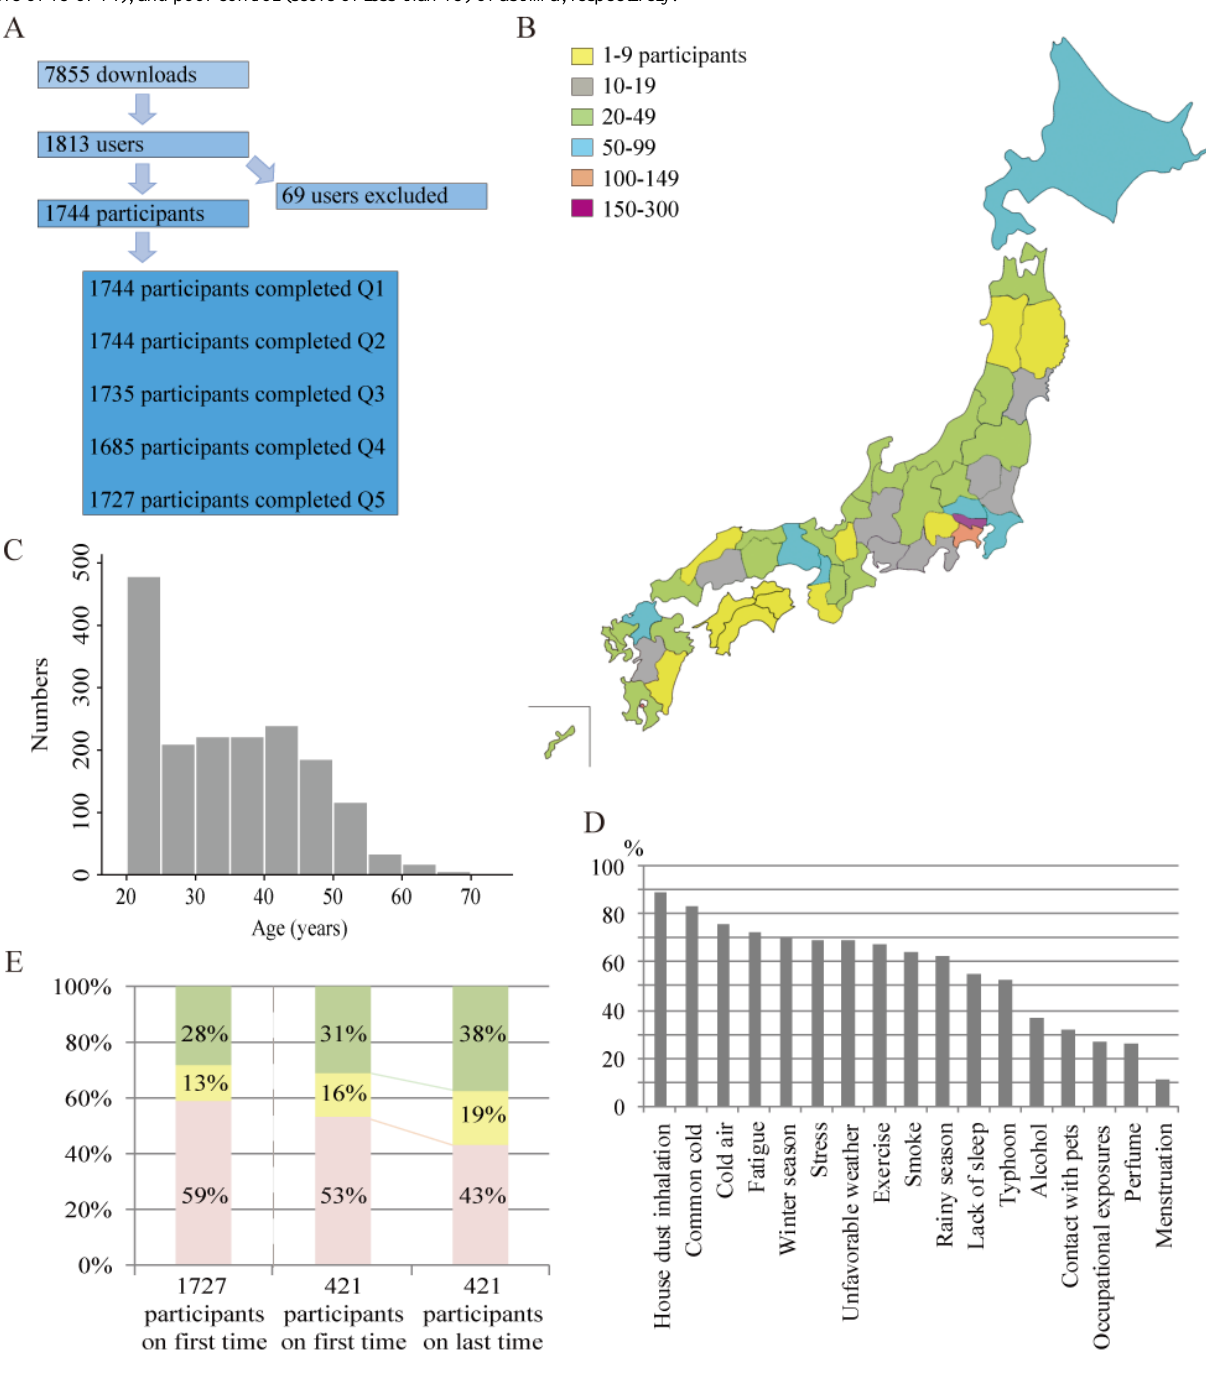
Figure 1. Recruitment process, geographic distribution, asthma triggers, and monthly Mobile Asthma Control Questionnaire (MACQ) surveys. (A) Patient recruitment process. (B) The geographic distribution of baseline users in Japan. (C) The age distribution of baseline users. (D) Percentages of factors that worsen asthma. (E) Proportion of patients with asthma control based on the MACQ surveys. The left column indicates the MACQ score for the 1727 patients who initially answered. Among the 421 patients who repeated the MACQ survey, the middle and the right column represents the MACQ score for the initial round and the last round, respectively. Green, yellow, and pink columns indicate total control (score of 15), well control (score of 13 or 14), and poor control (score of less than 13) of asthma,